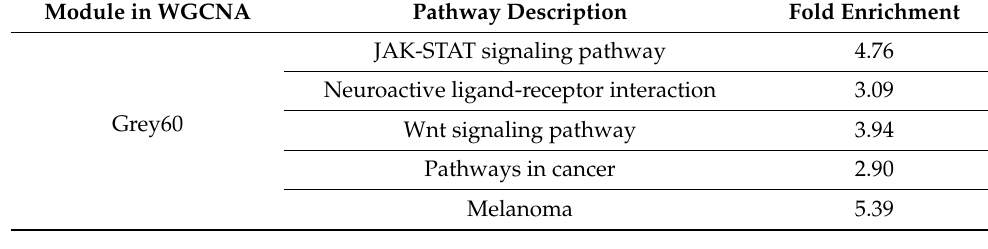
Table 6. Significant pathways in full chronicity.